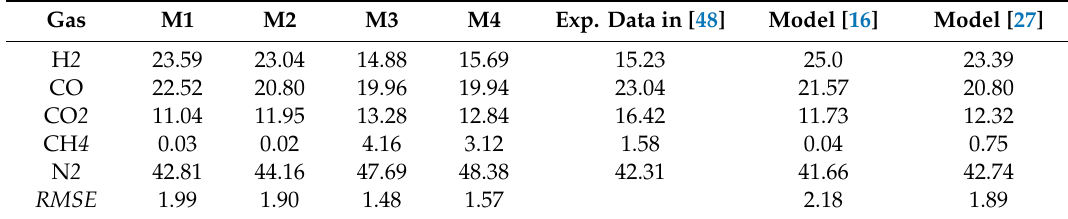
Table 6. Non-stoichiometric models validations in volume fractions (%) at T = 1073 K and MC =